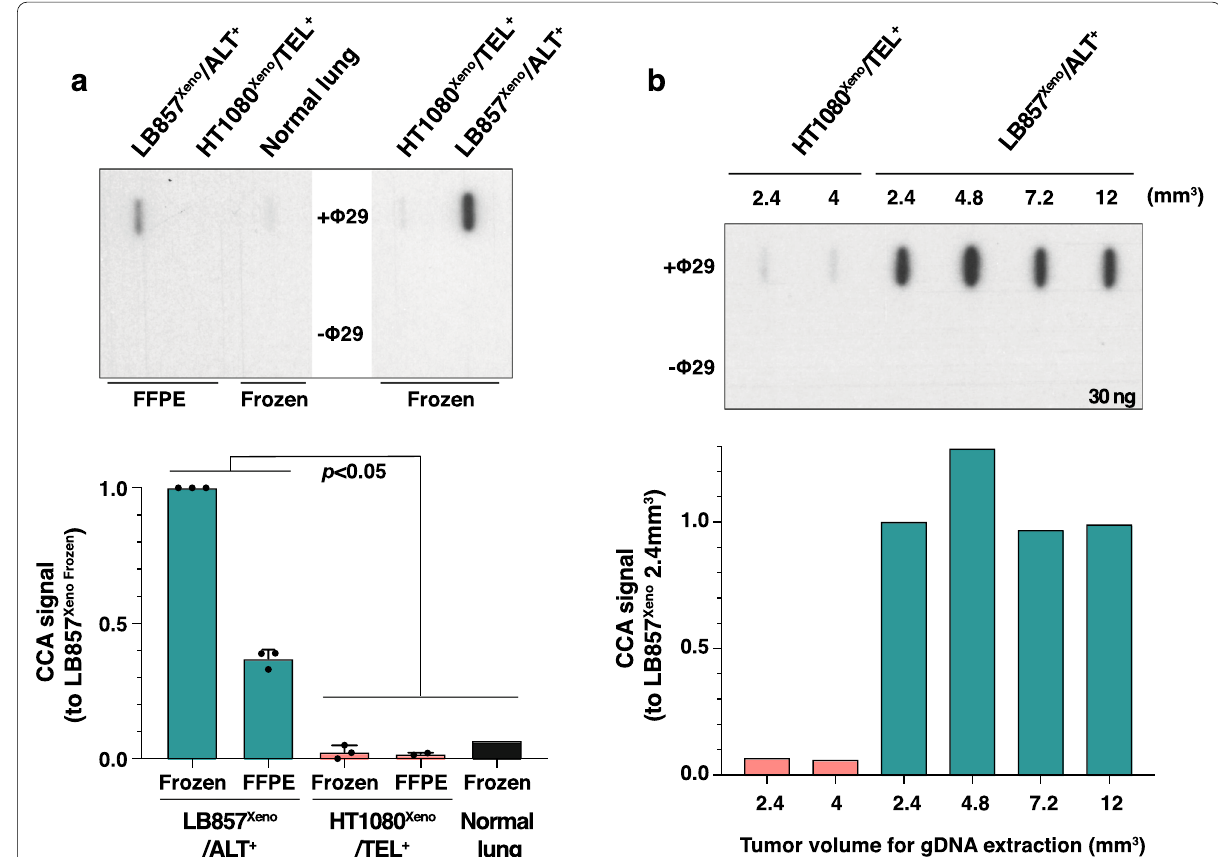
Fig. 4 C-circle detection from tumor tissue sections as another reliable ALT marker. a Slot-blot of the C-circle assay with ( Phi29 DNA polymerase performed on gDNA extracted from sections of either FFPE or frozen ALT + (green) and TEL + (pink) xenografts as indicated. Frozen human healthy lung tissue was used as control. Quantification of the slot-blot below shows mean on the frozen lung tissue while two to three independent experiments were performed on the xenograft tissues. Statistical analysis was performed using the nonparametric Mann-Whitney test to compare ALT + and ALT − groups. b Slot-blot of the C-circle assay with ( Phi29 DNA polymerase performed with 30 ng of gDNA extracted from different volumes of frozen LB857 Xeno /ALT + (green) or HT1080 Xeno /TEL + (pink) xenograft tissues as indicated. Quantification is shown below ( n